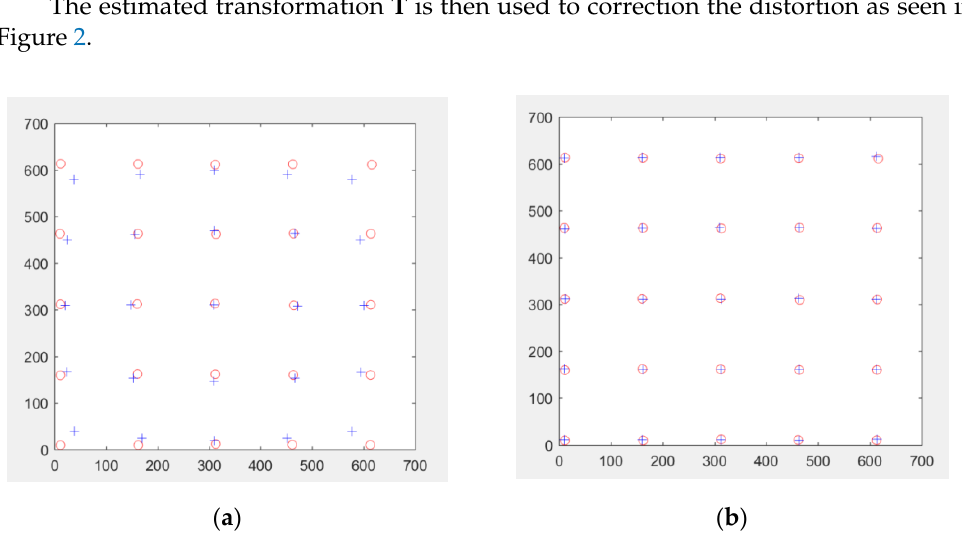
Figure 2. Distortion correction; ( a ) before correction, ( b ) after correction. Square is the non-distorted point of chess board phantom and + is the distorted capture point of the chess board phantom.